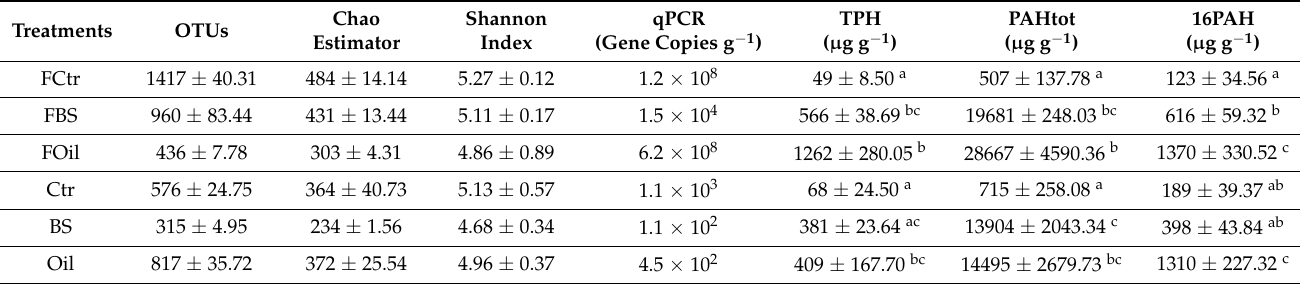
Table 1. Richness and diversity indices, real-time quantification of 16S rRNA (cDNA), and hydrocarbon quantification for all treatments after 75 days of the experiment, followed by standard deviation ( ± ). ANOVA was significant for community structure ( p < 0.01), total petroleum hydrocarbon (TPH) ( p = 0.40 × 10 − 3 ), total polycyclic aromatic hydrocarbon (PAHtot) ( p = 1.009 × 10 − 7 ), and 16PAH ( p = 1.52 × 10 − 6 ). Different letters represent statistically different samples. OTU,